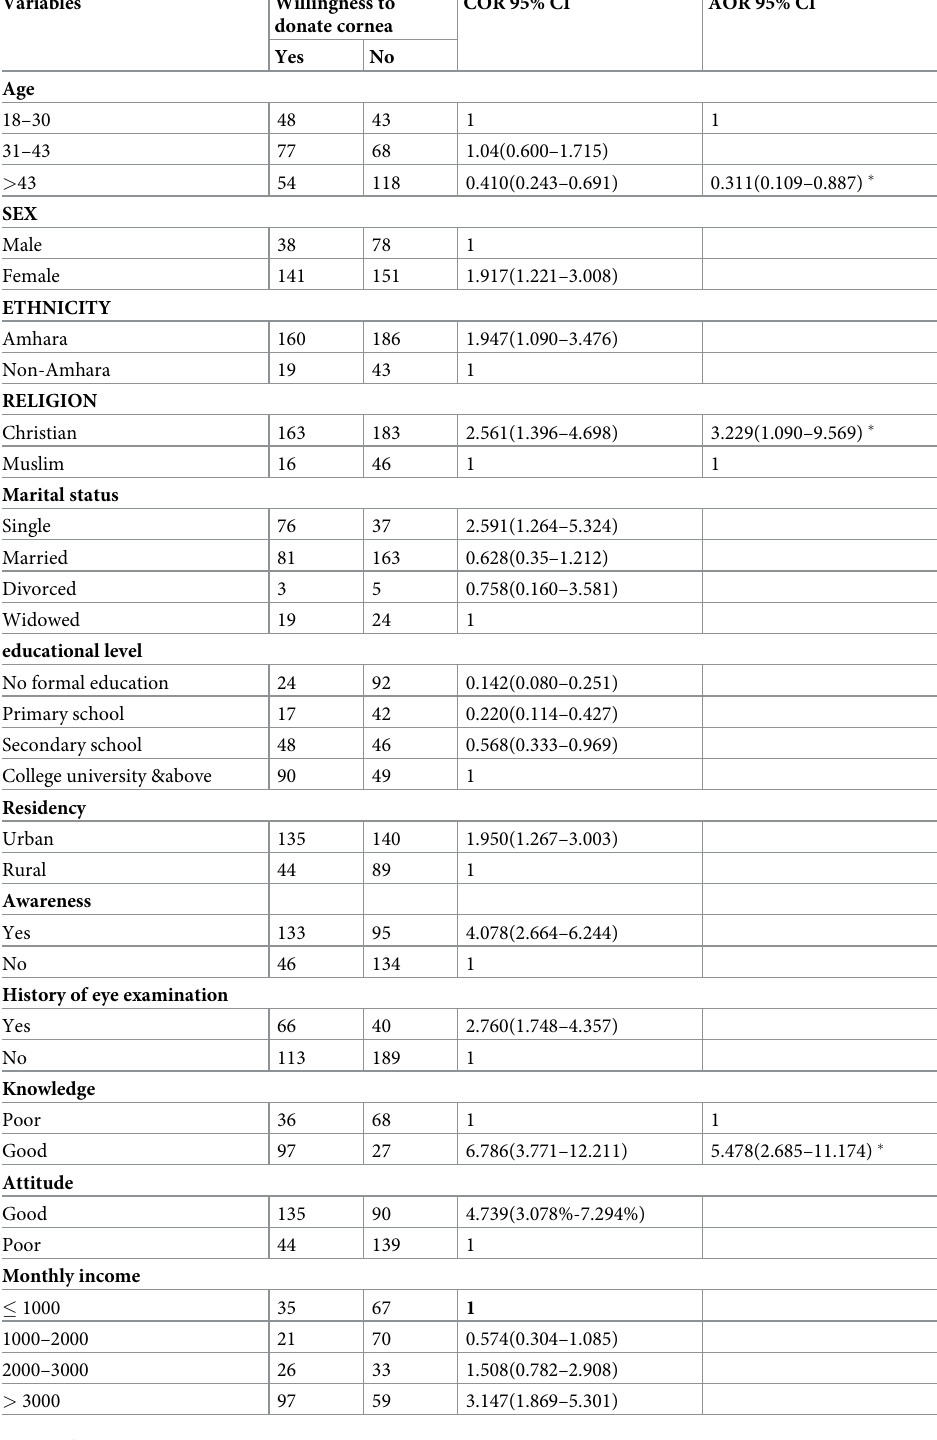
Table 4. Factors associated with willingness to donate cornea among patients attending University of Gondar Comprehensive and Specialized Hospital, July 2020.